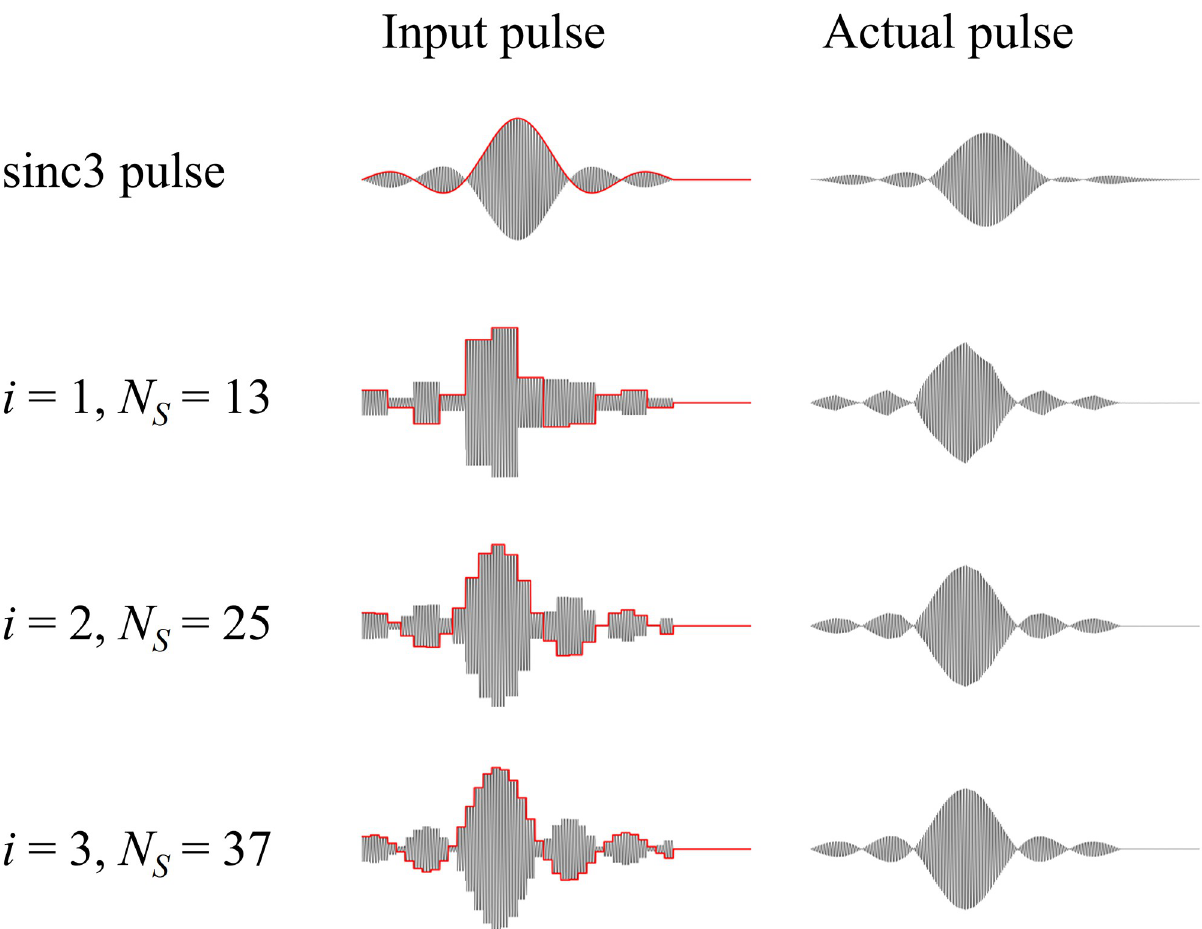
Fig 3. Input RF pulses (left column) and the signal generated by the RF coil (right column) for sinc pulse (top row), calculated pulses with N S = 13 = 25 (third row), N = 37 (bottom (second row), N S S